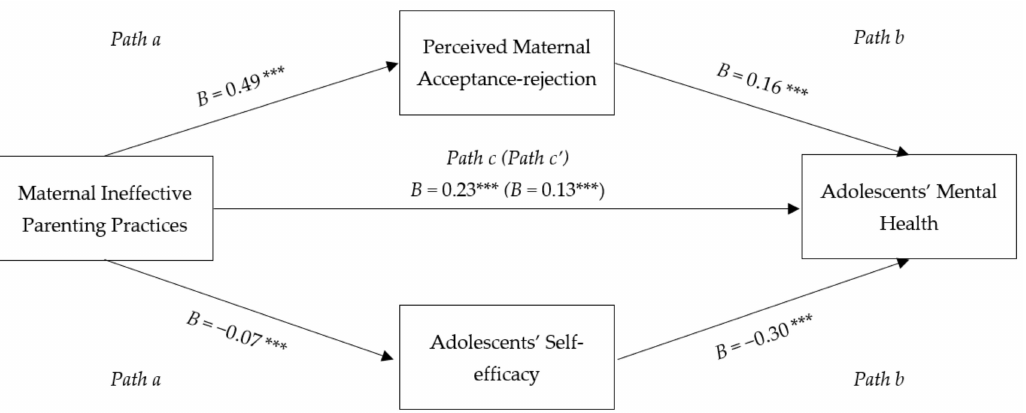
Figure 2. Mediation Model of the Relationship between Maternal Ineffective Parenting Practices and Adolescents’ Mental Health. Note. Coefficients presented are unstandardized regression coefficients. *** p <